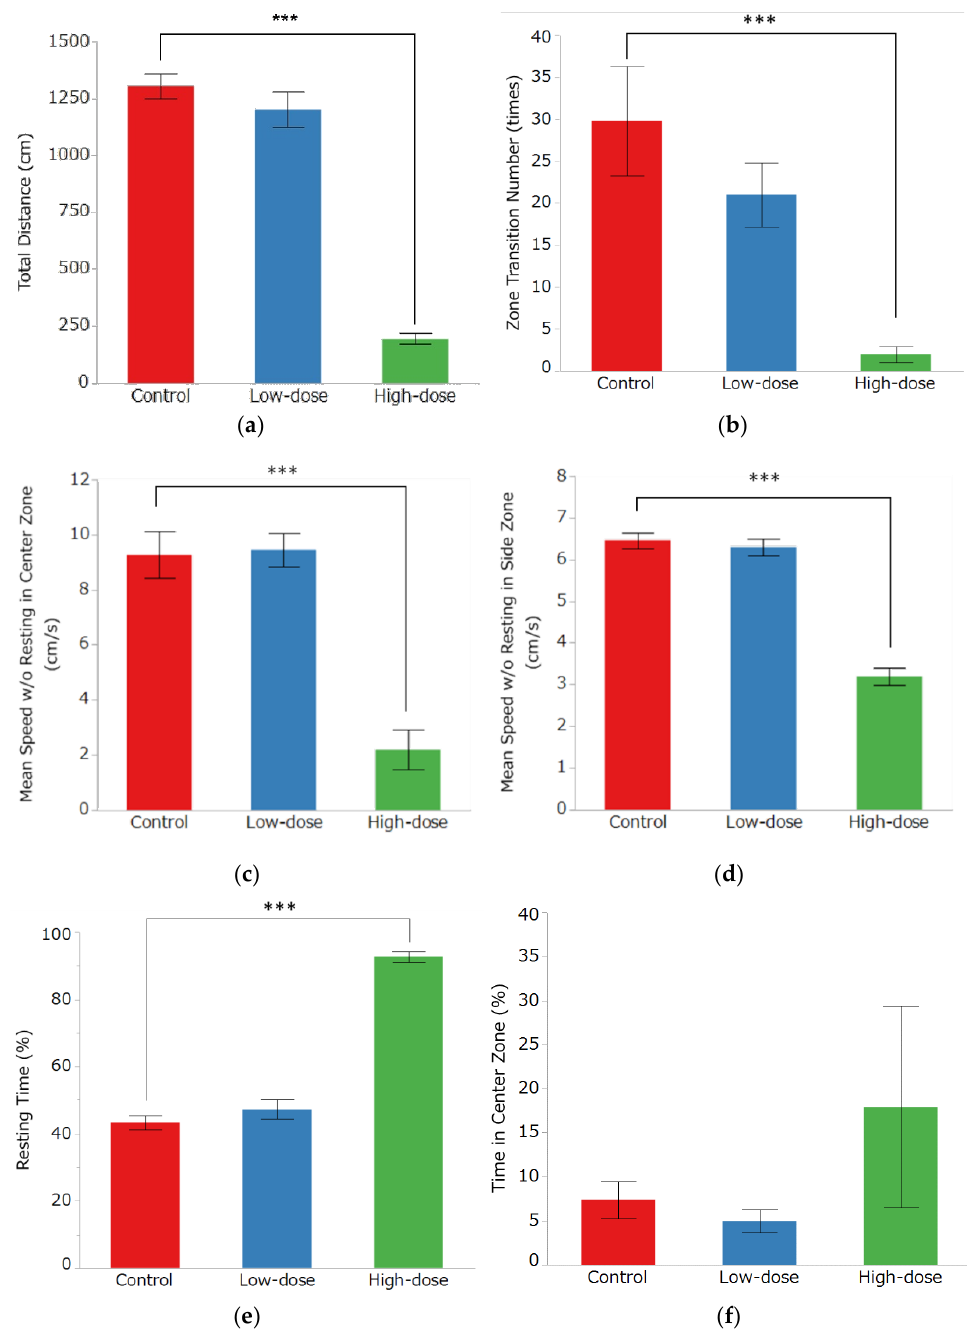
Figure 5. Behavioral effects of IMI administration in the open field test. ( a ) Total distance, ( b ) zone transition number, and mean speed without resting in ( c ) center zone and ( d ) side zone were significantly lower in the high-dose group than in the control group. ( e ) Resting time was significantly higher in the high-dose group than in the control group. ( f ) There were no significant differences among all groups in the time in center zone. Bar graphs indicate the mean ± SE of each group ( n = 8 per group), *** p < 0.001, Dunnett’s test.